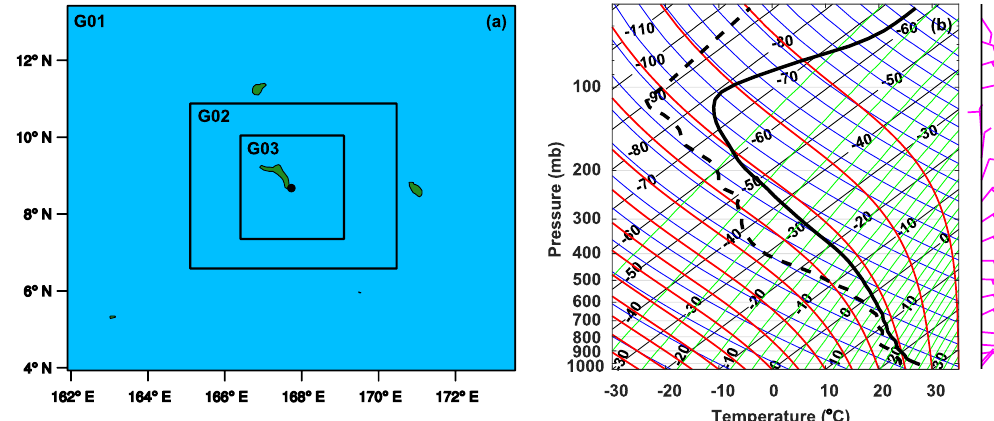
Figure 1. (a) Three nested domains over the Marshall Islands with horizontal grid spacing of 12km (G01), 2.4km (G02), and 0.48km (G03). (b) Mean vertical profiles of temperature ( ◦ C) and dew-point temperature ( ◦ C) at the initial time of the simulations in G03 (12:00UTC, 19 August 1999). The black dot (a ; center of G03) denotes the location of the Kwajalein S-band radar.